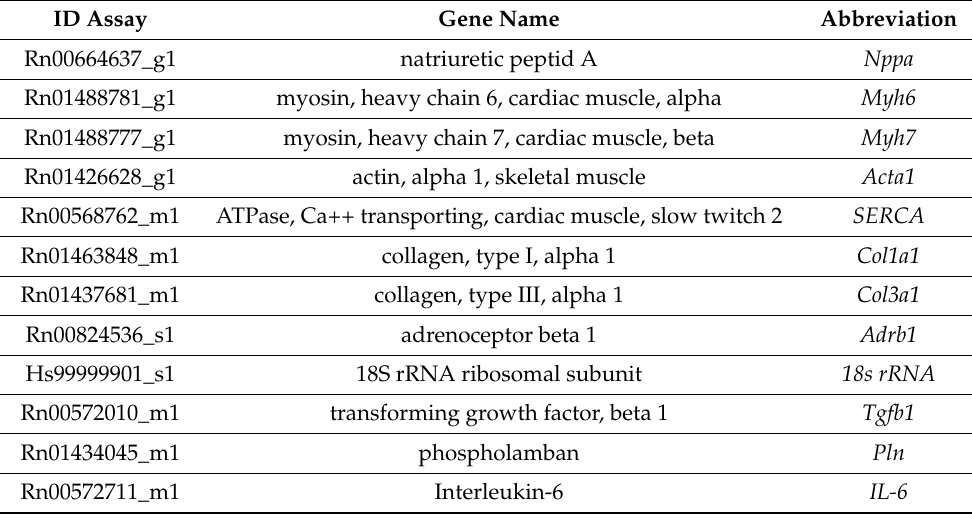
Table 1. The genes analyzed in the LV tissue.